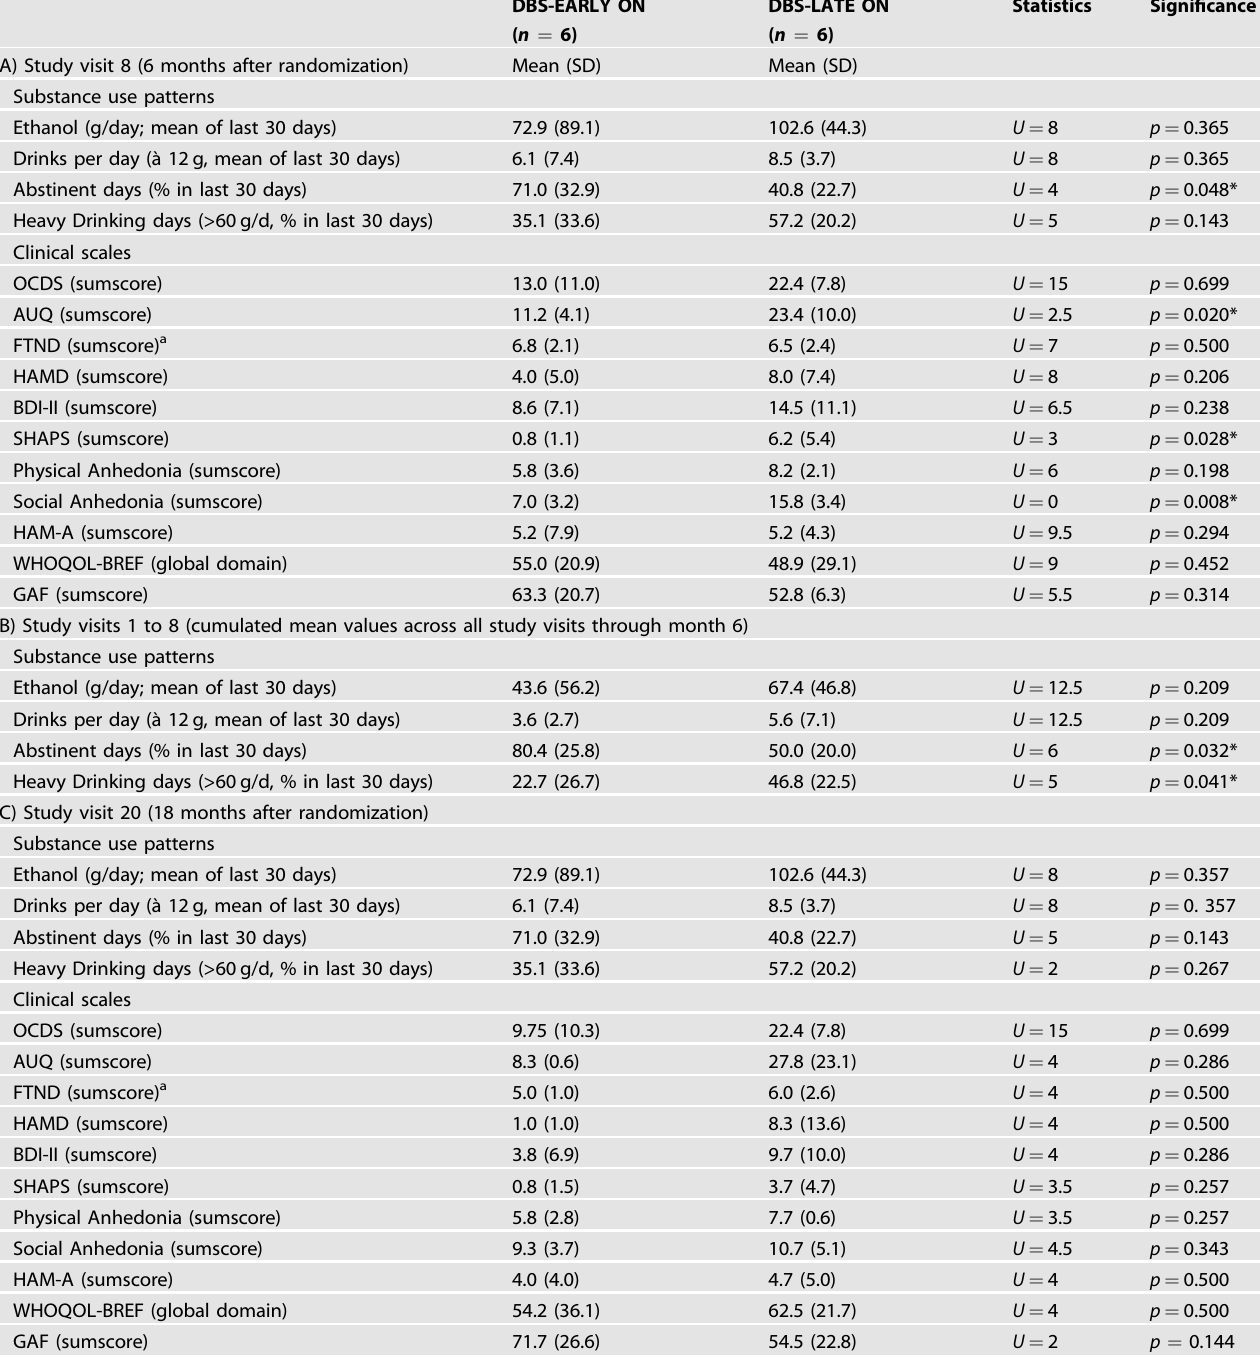
Table 2. Results of the comparison between the DBS-EARLY ON and DBS-LATE ON groups on alcohol use variables, psychometric measures of depression, anxiety, anhedonia and quality of life (A) at 6 months after randomization (i.e. study visit 8), as per the original study speci fi cation, (B) over all n = 8 study visits during the fi rst 6 months after randomization (cumulated mean values), and (C) at 18 months after randomization (i.e. study visit 20), as per the original study speci fi